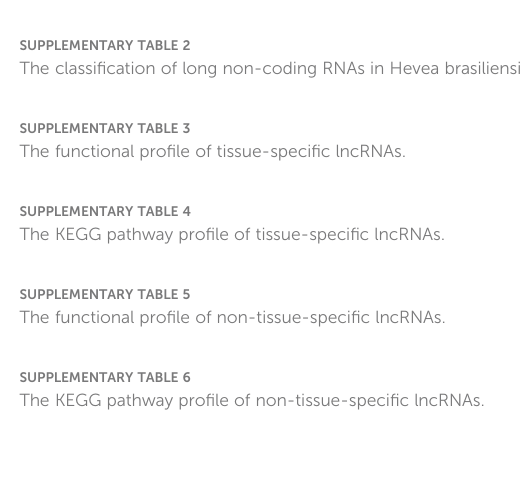
SUPPLEMENTARY TABLE 3 The functional pro fi le of tissue-speci fi c